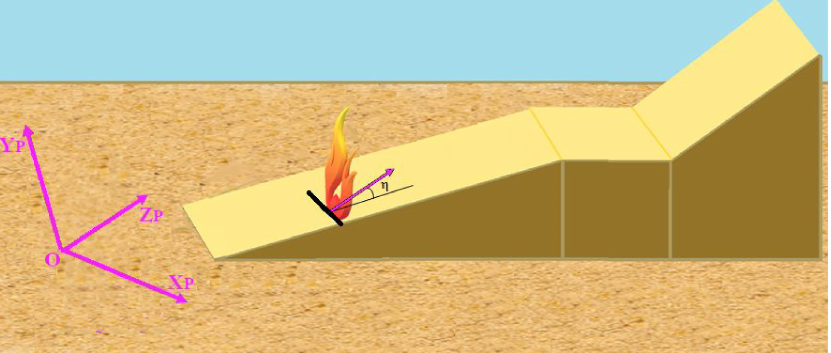
Figure 10. Depth axis of the global frame corresponding to the instantaneous fire direction. The pink vector represents the instantaneous direction of the